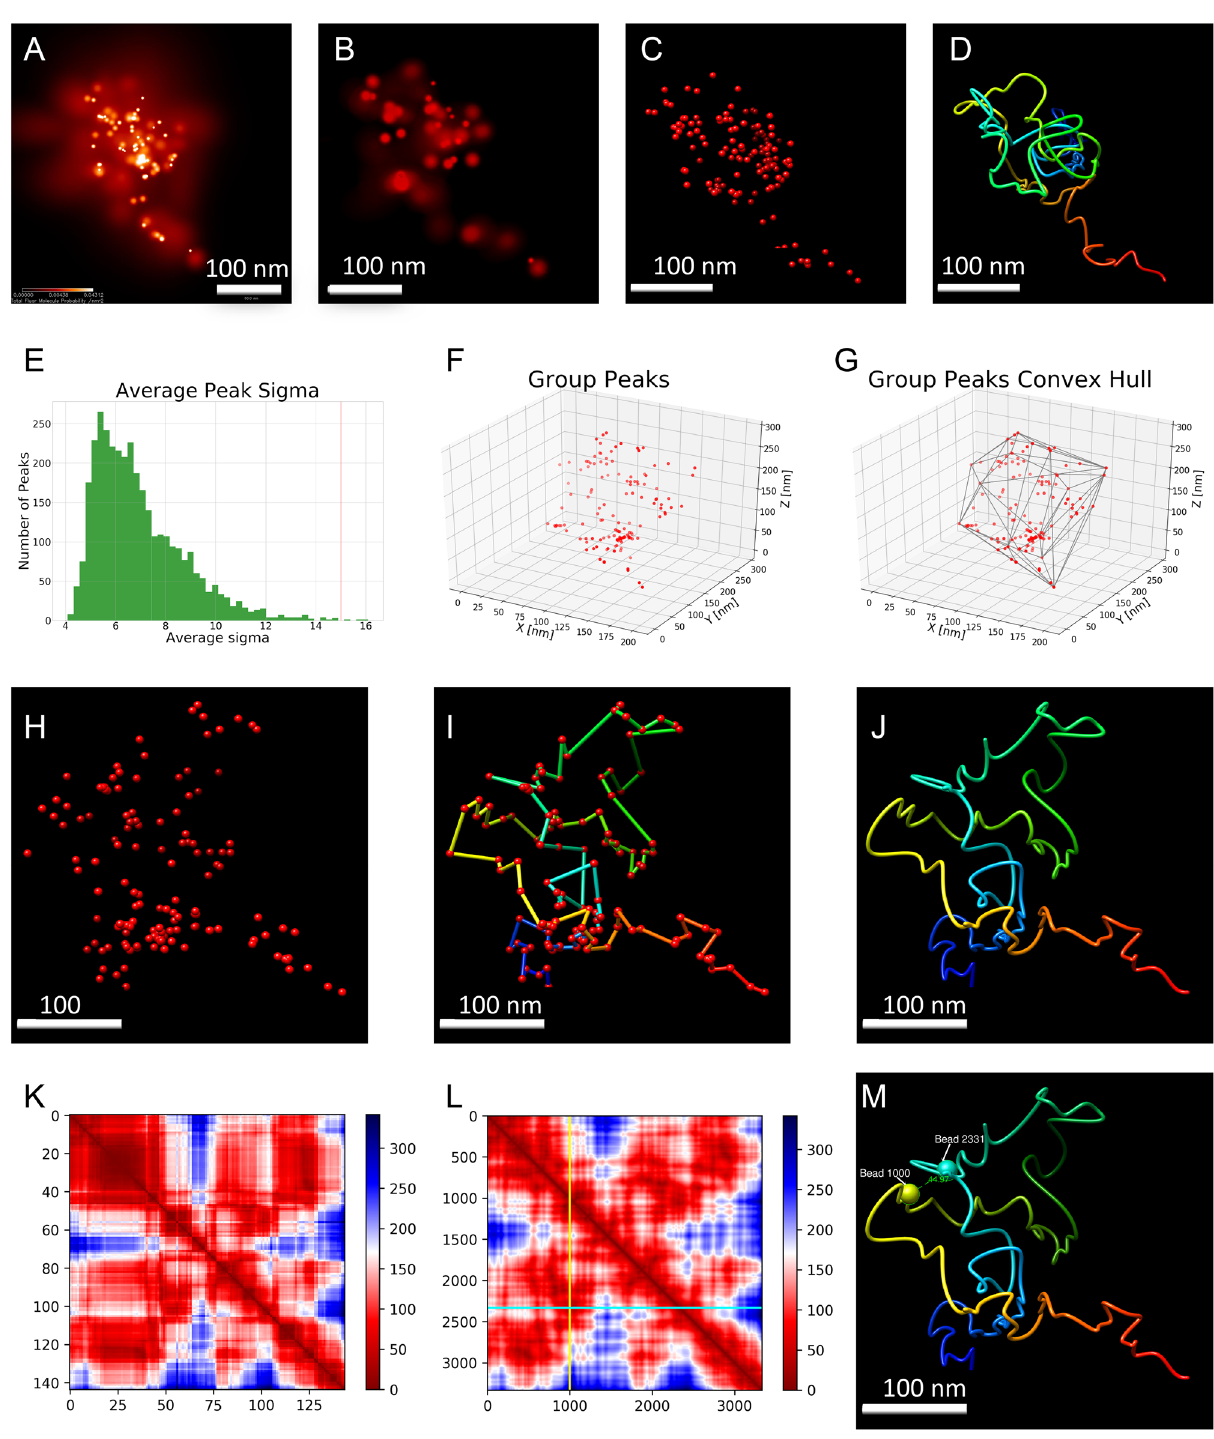
Figure 2. Processing and modeling pipeline for iPALM images based on image #17. ( A ) 2D image of the target chromatin region generated by PeakSelector. Color bar represents the probability of molecule presence per nm 2 with white and dark red colors representing the high and low probability respectively. ( B ) 3D image of the target chromatin region ( C ) Group peaks visualized as points in 3D space. ( D ) 3D polymer model reconstructed from group peaks. The blue color represents the beginning of the model structure, red color represents the end. ( E ) Average sigma for each peak in the image. ( F ) 3D position plot of group peaks. ( G ) The convex hull of group peaks. ( H – J ) Modeling pipeline used to reconstruct chromatin loop in image # 17 ( H ) Group peaks in 3D space ( I ) Model generated by connecting group peaks using travelling salesman problem-solving algorithm (TSP). ( J ) Model smoothed using spline interpolation. ( K ) Distance heatmap from TSP model showing physical distances (in nm) between pairs of beads in the model. ( L ) Distance heatmap from interpolated TSP model showing physical distances (in nm) between pairs of beads in the model. Dashed lines represent loop anchors, (also shown in Fig. 2 M as yellow and teal spheres). ( M ) 3D model of chromatin loop captured in image #17. Beads 1000 (cyan) and bead 2331 (yellow) mark loop anchors. Distance (44.97 nm) between anchors is also